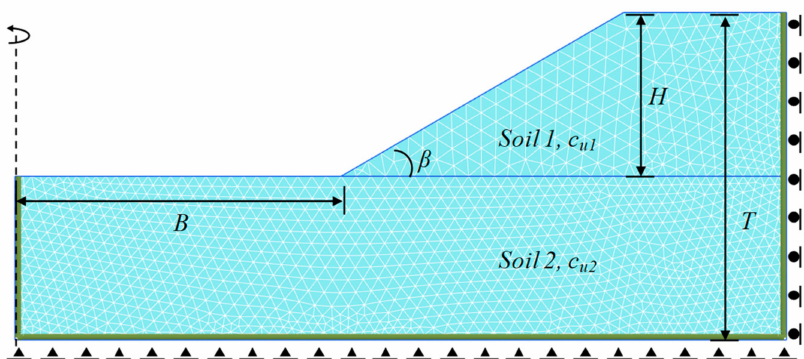
Figure 4. Typical finite element mesh and boundary